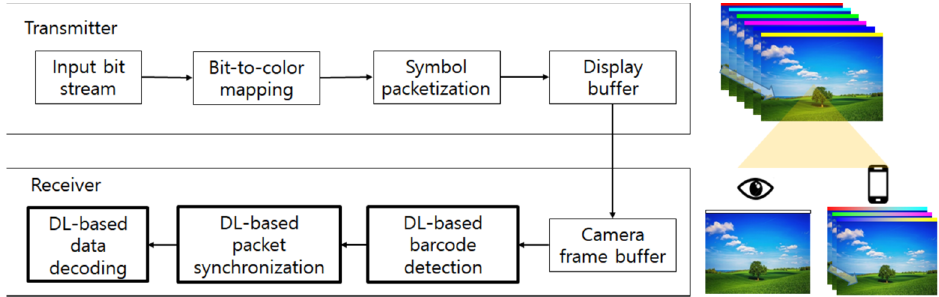
Figure 1. The system model for DeepCCB-OCC. To transmit information using the DeepCCB-OCC system, it is necessary to match the transmission symbol and the color value. The complementary color relationship of the DeepCCB-OCC system was constructed using the hue circle shown in Figure 2. Primary and complementary colors are located 180 degrees from each other on the hue circle. For primary colors (red, green, and blue), the complementary colors are cyan, yellow, and magenta. When primary and complementary colors are added, the R, G, and B channel values are 255, resulting in white. When the primary and complementary colors appear in succession through the display’s fast refresh rate, the human eye sees the combination of the two colors as white. This allows additional information that is unobtrusive to the human eye to be transmitted through the display. As can be seen in the figure, eight symbols constitute the hue circle, and each symbol consists of three bits. Grey coding is used to minimize the bit error rate in the decoding process. Each symbol is expressed as the intensity value of the red (R), green (G), and blue (B) channels, and the color value for each channel for the eight symbols used in CCB-OCC is shown in Figure 2.